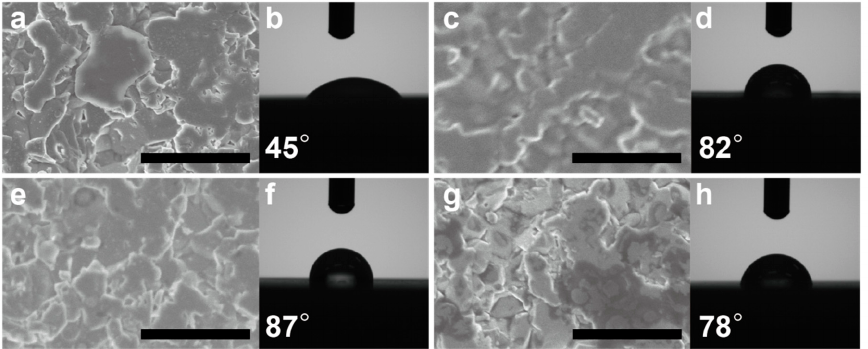
Figure 1. Top surface structures ( a , c , e , g ) and water-drop contact angle measurements (b, d, f, h) of the ( a , b ) cobalt tetraphenylporphyrin (CoTPP), ( c , d ) cobalt tetraphenylporphyrin ethylcellulose (CoTPP-EC), ( e , f ) cobalt tetraphenylporphyrin polystyrene (CoTPP-PSt), and ( g , h ) cobalt tetraphenylporphyrin polycyclohexyl methacrylate (CoTPP-PCHMA) films. Scale bar: 5 μ m.